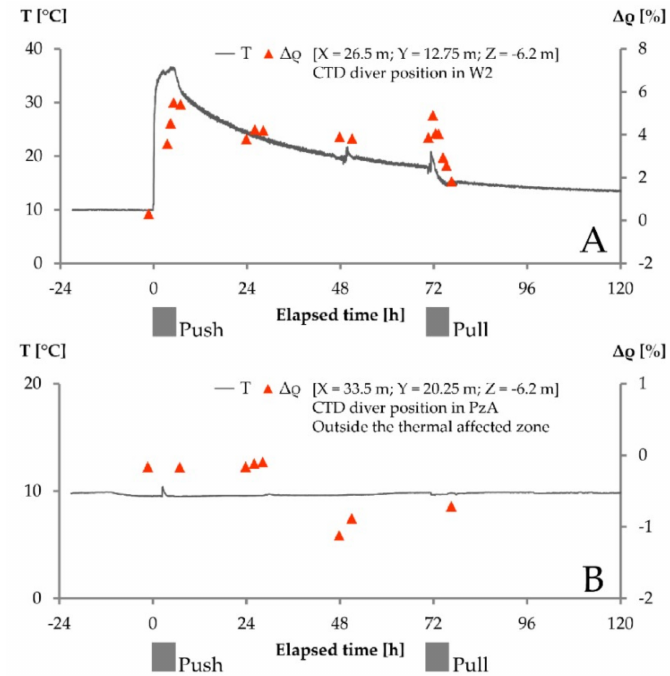
Figure 10. Changes in bulk electrical resistivity in comparison with changes in groundwater temperature at well W2 location (depth of 6.2 m, position of the CTD diver) ( A ) and outside the thermal a ff ected zone, at piezometer PzA location (depth of 6.2 m, position of the CTD diver) ( B ).